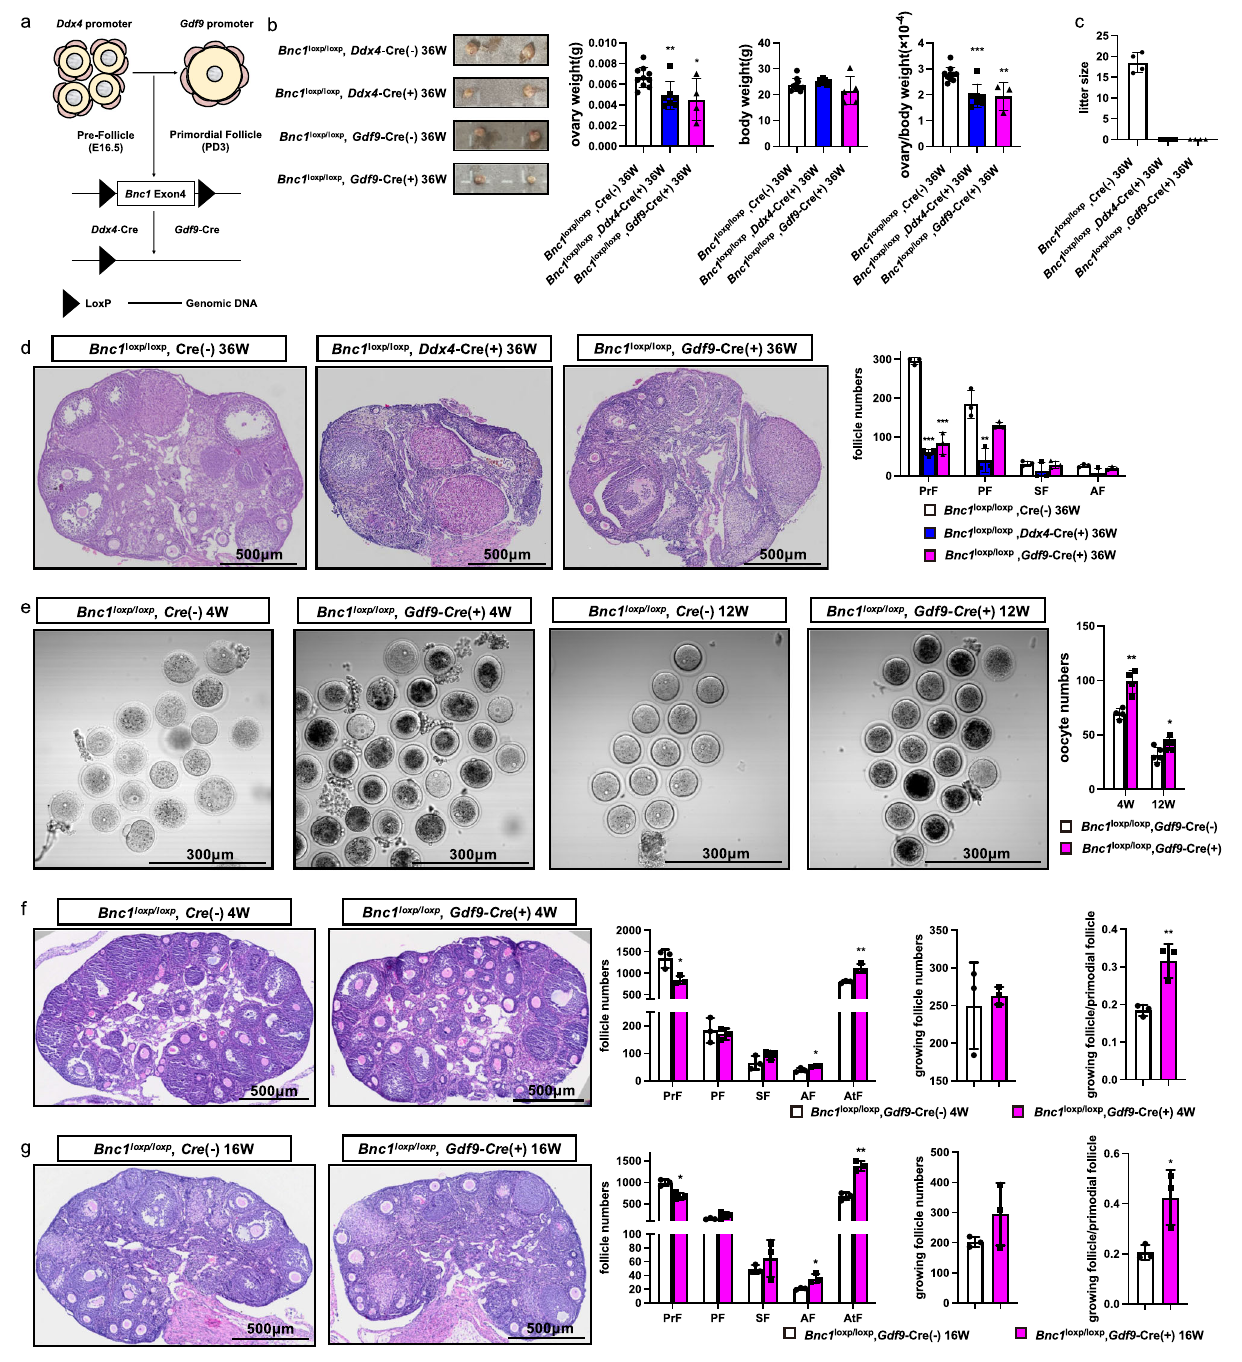
Fig. 2 | Bnc1 affects follicle development by in fl uencing oocytes. a Schematic representation of the deletion of Bnc1 exon 4 in oocytes of pre-follicles, PrFs by using Ddx4 and Gdf9 -Cre transgenic. b Ovary weight, body weight and ovary weight/body weight ratios of Bnc1 loxP/loxP , Cre ( − ) ( n =9), Bnc1 loxP/loxP , Ddx4 -Cre (+) ( n =7, p value=0.0069 for ovary weight, p value=0.2647 for body weight, p value=0.0003 for ovary weight/body weight) and Bnc1 loxP/loxP , Gdf9 -Cre (+) ( ≥ 3, p value=0.0179 for ovaryweight, p value=0.2835forbodyweight, p value=0.0029 forovaryweight/bodyweight)miceat36weeks. c Averagelittersizesof Bnc1 loxP/loxP , Cre ( − ) ( n =4), Bnc1 loxP/loxP , Ddx4 -Cre (+) ( n =5, p value<0.0001) and Bnc1 loxP/loxP , Gdf9 -Cre (+) ( n =4, p value<0.0001) female mice. d Comparison of follicle